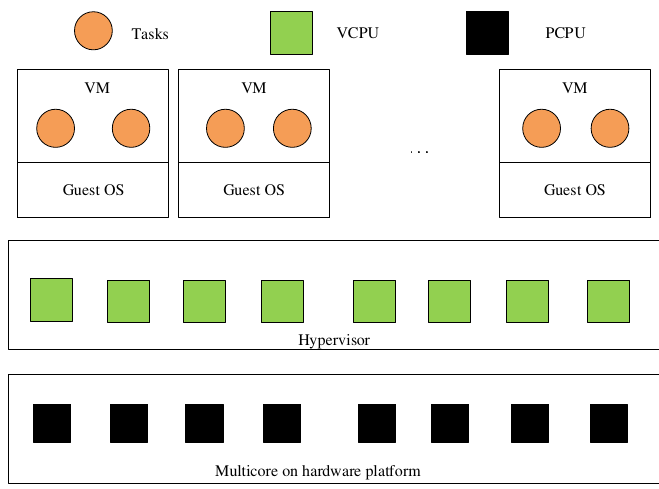
Figure 1. Virtualization hierarchical scheduling